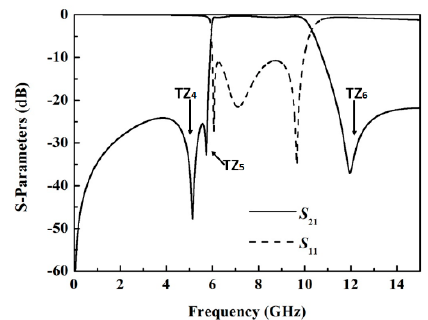
Figure 7. Simulated results of the second UWB BPF using EM simulation. For the second UWB BPF, L 1 ’ = 1.85 mm, L 2 ’ = 3.1 mm, L s ’ = 6.95 mm, L c ’ = 5.92 mm, W 1 ’ = 3.43 mm, W 2 ’ = 0.2 mm, W s ’ = 0.2 mm, G 1 ’ = 0.2 mm, G 2 ’ = 0.15 mm, G 3 ’ = 0.15 mm.